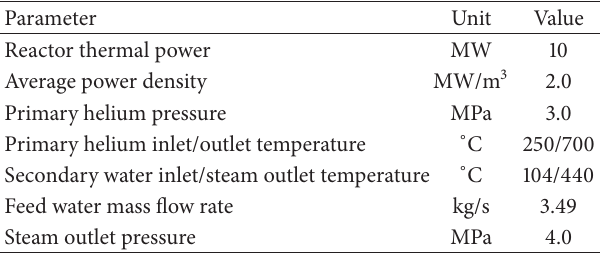
Table 1: Main design parameters of the